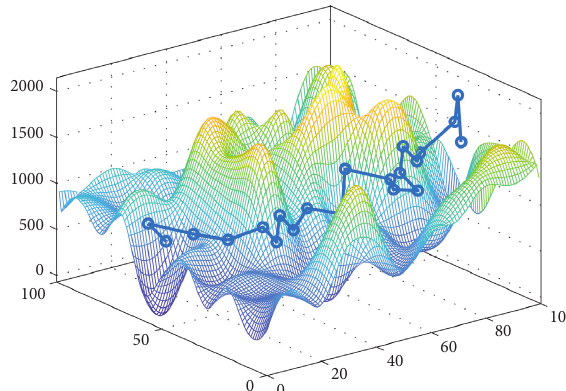
Figure 8: Trend of algorithm accuracy.